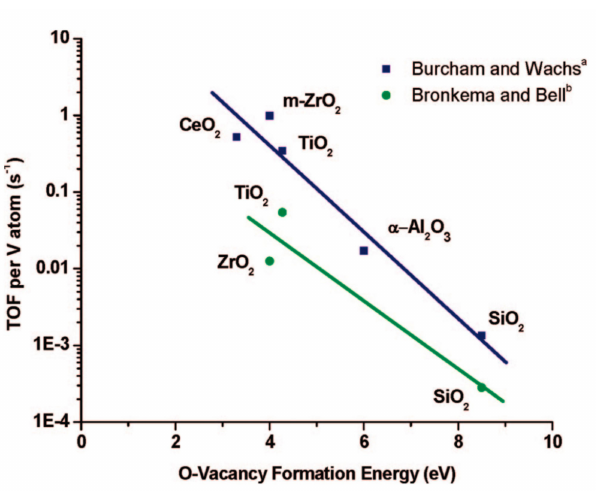
Figure 30. TOF per V atom for MeOH oxidation as function of the O-vacancy formation energy. a [184]; b [172,173,189]. Reprinted from [190] Copyright © (2008) American Chemical